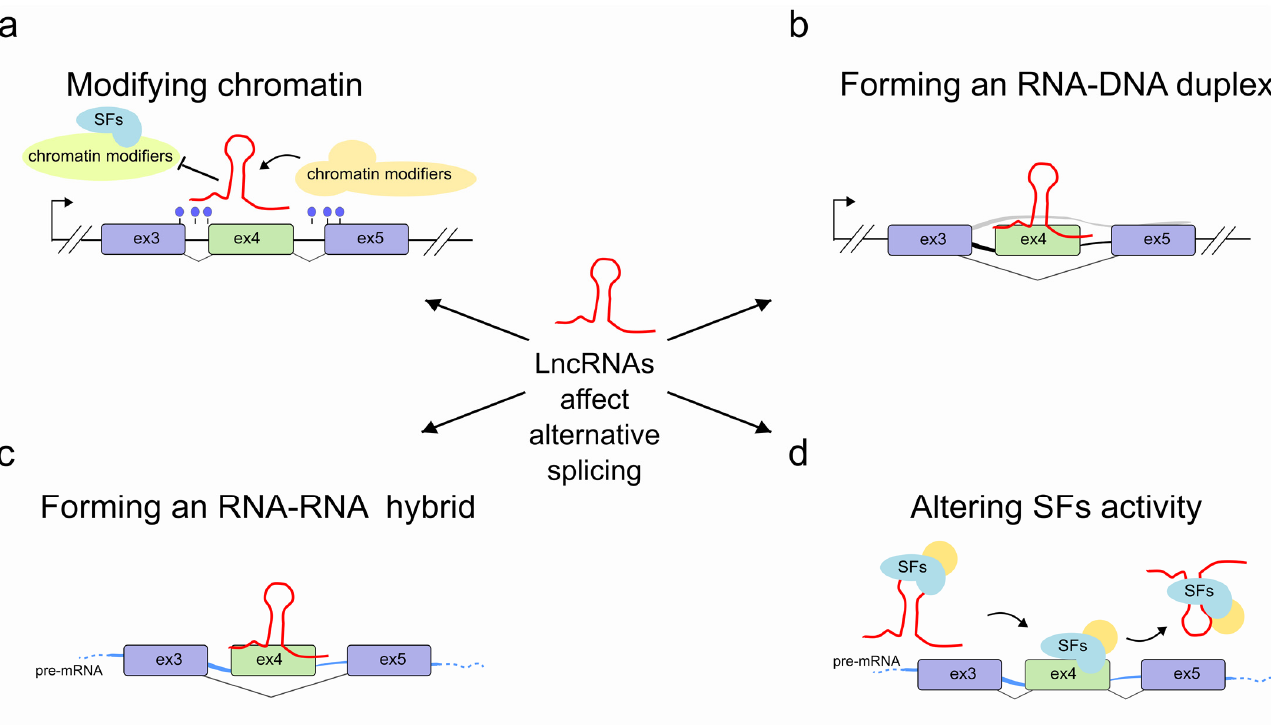
Figure 1. Regulation of pre-mRNA splicing by lncRNAs. LncRNAs (red) are able to control pre-mRNA splicing by ( a ) modifying chromatin accessibility through recruiting or impeding access to chromatin modifying complexes at the transcribed genomic locus. In some cases, this might result in more drastic long-range structural changes; ( b ) interacting with the transcribed genomic locus through an RNA-DNA hybrid; ( c ) hybridizing with the pre-mRNA molecule (light blue); ( d ) promoting SF recruitment or by sequestering SFs into specific subnuclear compartments, thereby interfering with SF activities. SF